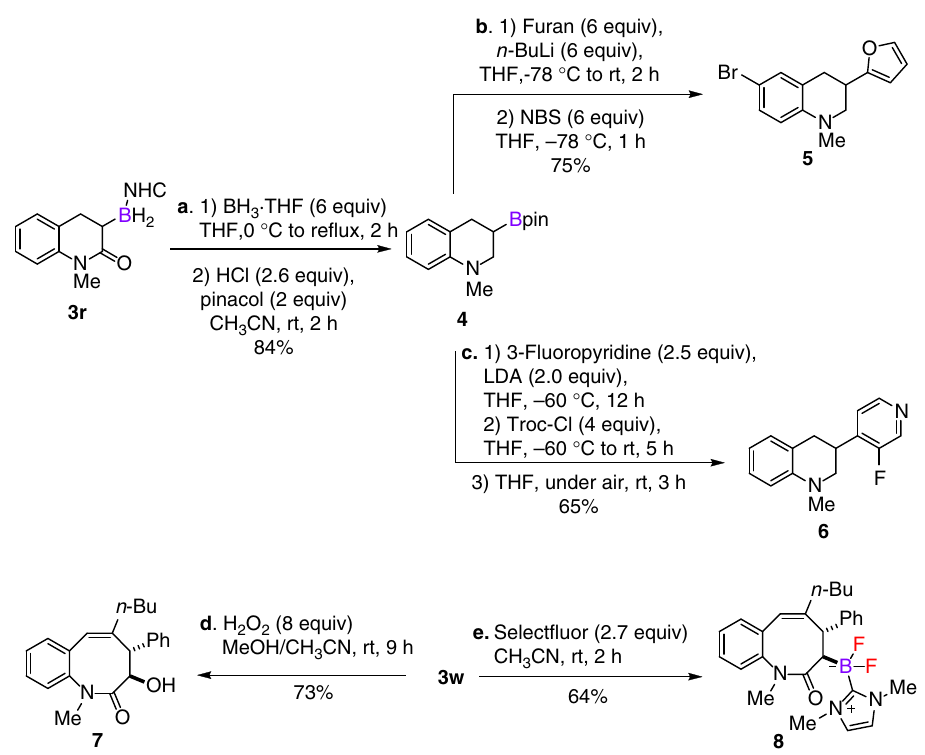
Fig. 2 Diversi fi cation of α -borylcarbonyl compounds. a Synthesis of 3-boron-substituted tetrahydroquinoline 4 via a one-pot transformation from 3r . b Synthesis of 3-furan-substituted tetrahydroquinoline 5 . c . Synthesis of 3-pyridine-substituted tetrahydroquinoline 6 . d Synthesis of α -hydroxy product 7 by the direct oxidation of the boron moiety. e Synthesis of NHC − di fl uoroboranes 8 from